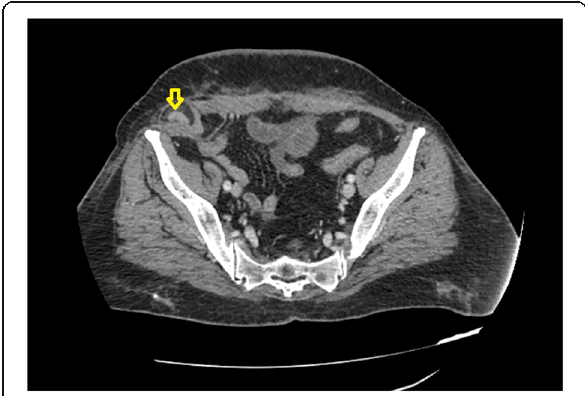
Fig. 1 Axial CT with IV contrast showing the inflamed appendix (yellow arrow) passing through the hernia defect. Noted fat stranding and rim of fluid collection surrounding the appendix